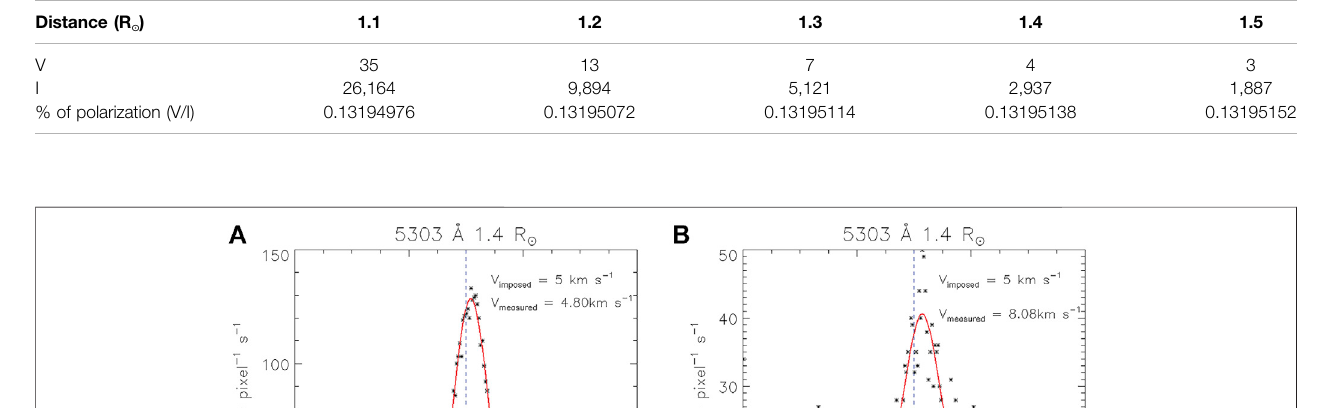
Frontiers in Astronomy and Space Sciences |